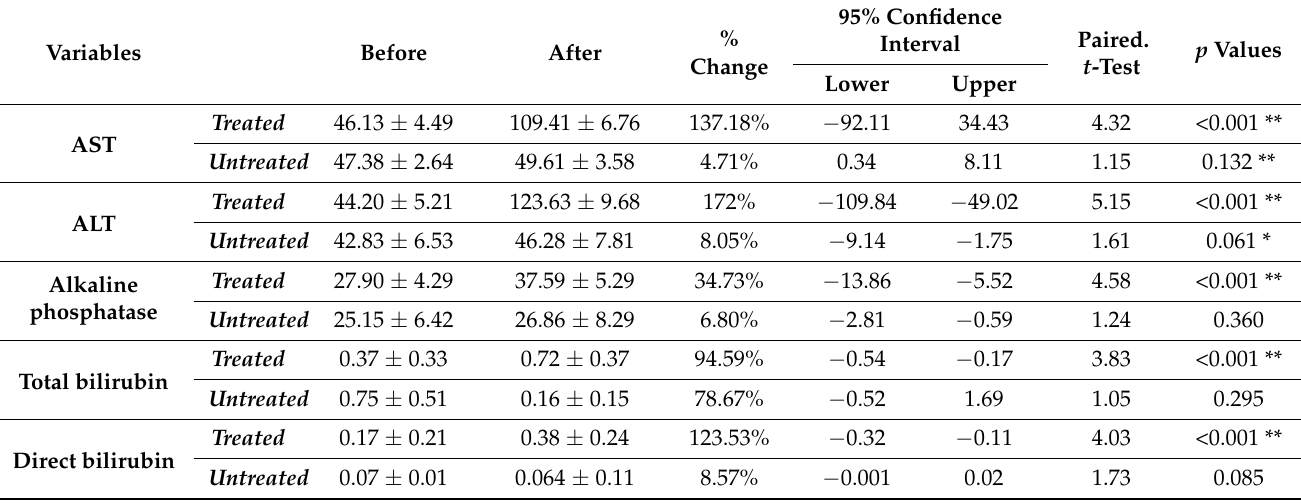
Table 4. Comparison between before and after according to treatment with FVP.